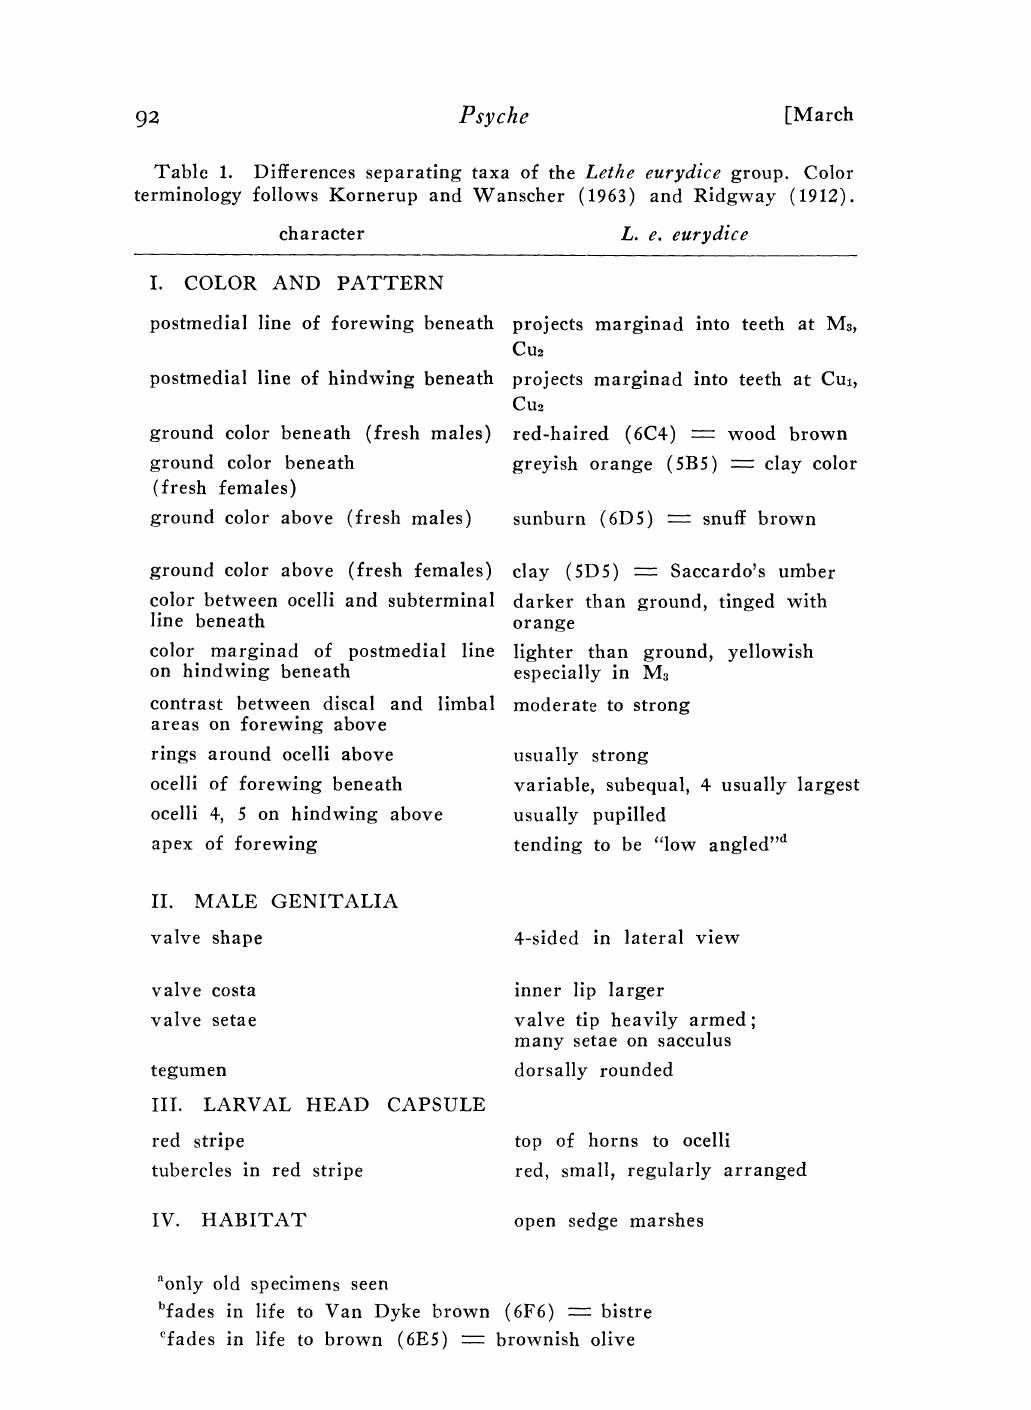
Table 1. Differences separating taxa of the Lethe eurydice group. Color terminology follows Kornerup and Wanseher (1963) and Ridgway (1912).